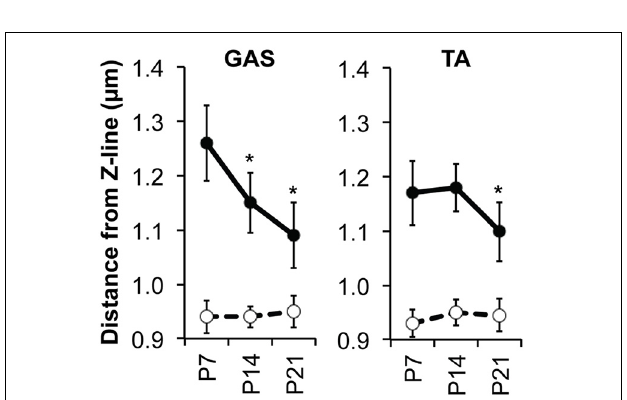
FIGURE 2 | Thin filament lengths during postnatal muscle development in mice. Graphs depict distances of Tmod (solid circles) and nebulin M1M2M3 (open circles) from the Z-line in GAS and TA muscles from P7 to P21 mice. Tmod distance reflects the variable position of the thin filament pointed end with respect to the Z-line, while nebulin M1M2M3 distance reflects the relatively constant position of the proximal/distal segment boundary of the thin filament with respect to the Z-line (Gokhin and Fowler, 2013). Tmod distances reflect pooled Tmod1 and Tmod4 distances. Error bars reflect mean ± SD for n ≥ 100 myofibrils/time-point for Tmod, n ≥ 50 myofibrils/time-point for nebulin M1M2M3. ∗ p < 0 . 01 with respect to the previous time-point.